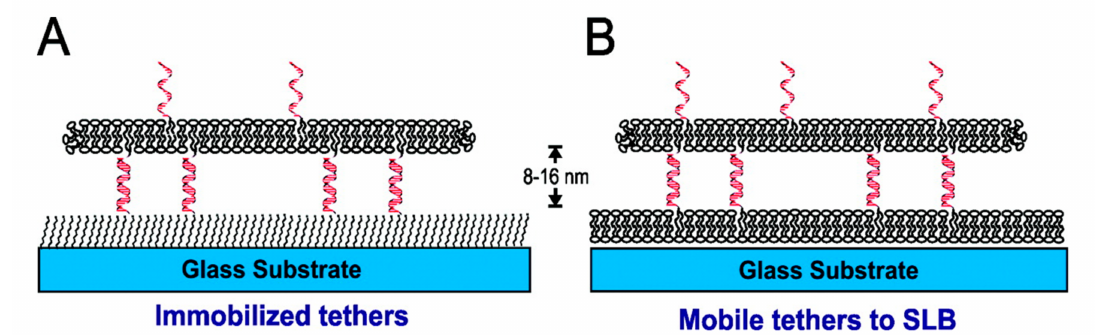
Figure 7. Schematic diagram of DNA-tethered lipid bilayer patches formed by rupture of giant unilamellar vesicles on two di ff erent substrates. In part A , the tethering DNA is covalently attached to the substrate and so the DNA tethers are not mobile (the lateral density can be controlled; the remainder of the surface is passivated with phosphate groups). In part B , the tethering DNA is displayed on the surface of a supported lipid bilayer, so the DNA tethers are laterally mobile. This design brings two fluid bilayers into proximity defined by the length of the DNA tether (~8 nm for a 24mer hybrid; ~16 nm for a 48-mer hybrid). (Reproduced with permission from [133], copyright 2011 American Chemical